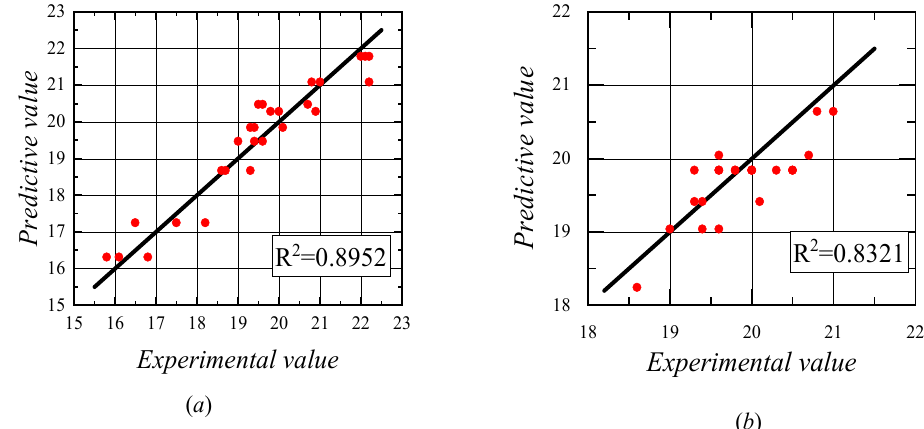
Figure 12. Comparison of the test values and predicted values. ( a ) the ratio of concrete cover to reinforcing steel diameter is greater than 4.5; ( b ) the ratio of concrete cover to reinforcing steel diameter is less than 4.5.